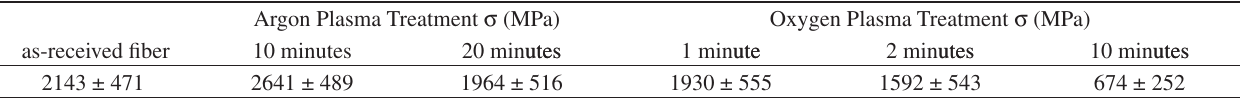
Table 2. Tensile strength ( σ ) of carbon fiber samples untreated and treated with argon and oxygen plasmas. Argon Plasma Treatment σ